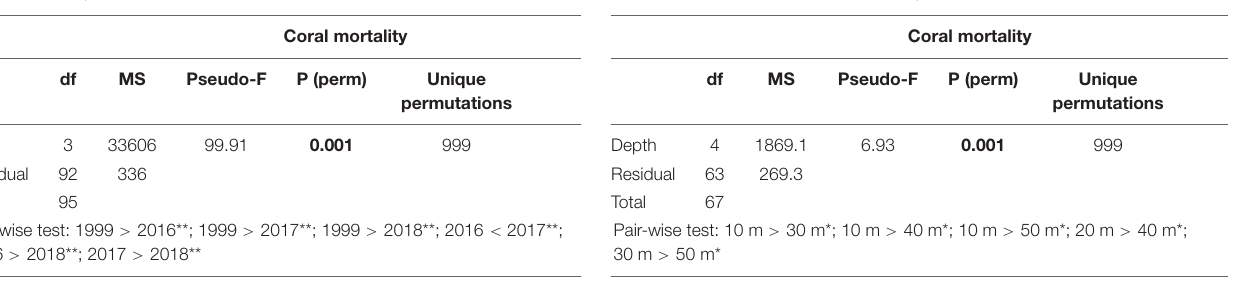
TABLE 5 | Results of one-way PERMANOVA on coral mortality across depths (10, 20, 30, 40, and 50 m) when coral mortality occurred in the Maldives (pooling data from 1999, 2007, 2016, 2017, and